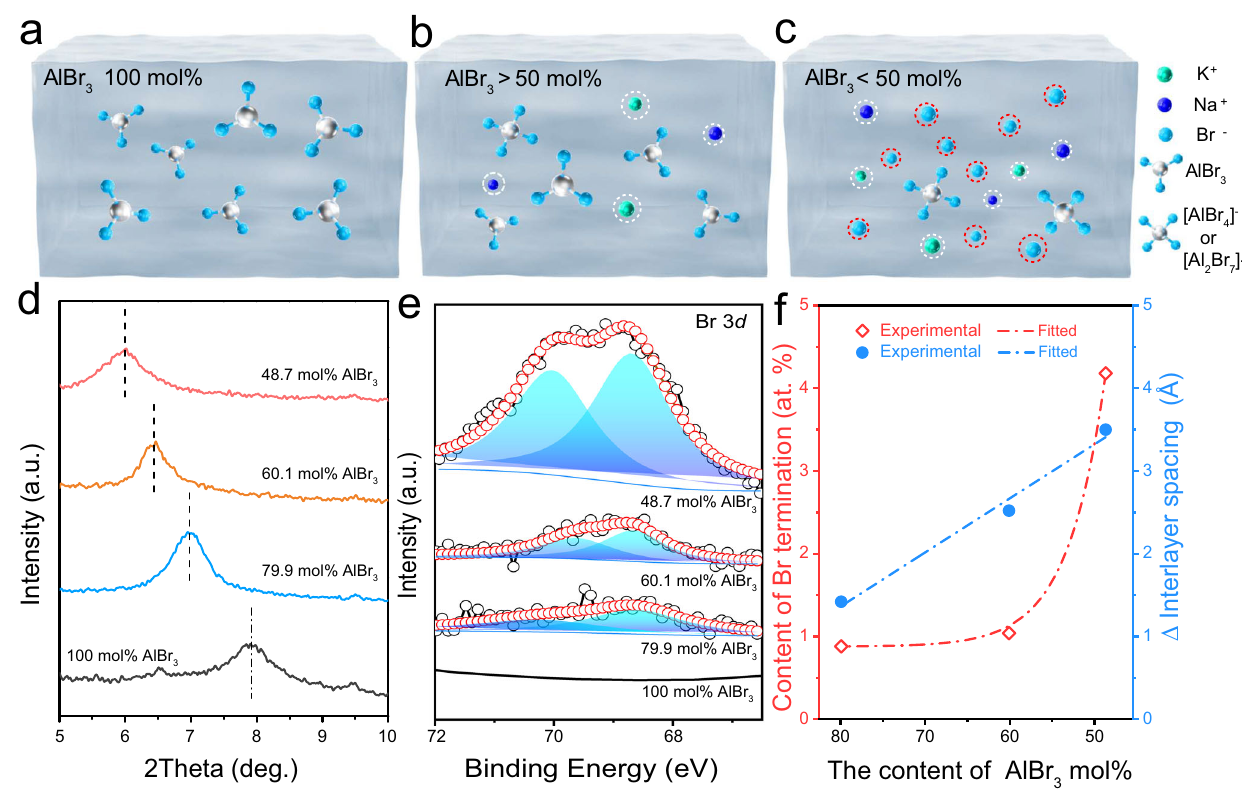
Fig. 2 | Mechanism of Lewis-basic halides treatment. a – c Substance component of AlBr 3 /NaBr/KBr molten salt with different percentages ofAlBr 3 inside. a There is only AlBr 3 molecular in pure molten state AlBr 3 salt (100mol% AlBr 3 ). b For AlBr 3 / NaBr/KBr with more than50mol% AlBr 3 , [Al 2 Br 7 ] − , [AlBr 4 ] − ions in equilibrium with aluminum bromide (in the form of Al 2 Br 6 and AlBr 3 ) are present with less des- olvated Na + and K + . c For AlBr 3 /NaBr/KBr with less than 50mol% AlBr 3 , abundant desolvated Br − , Na + , and K + exist in molten salts (light green balls: potassium, blue